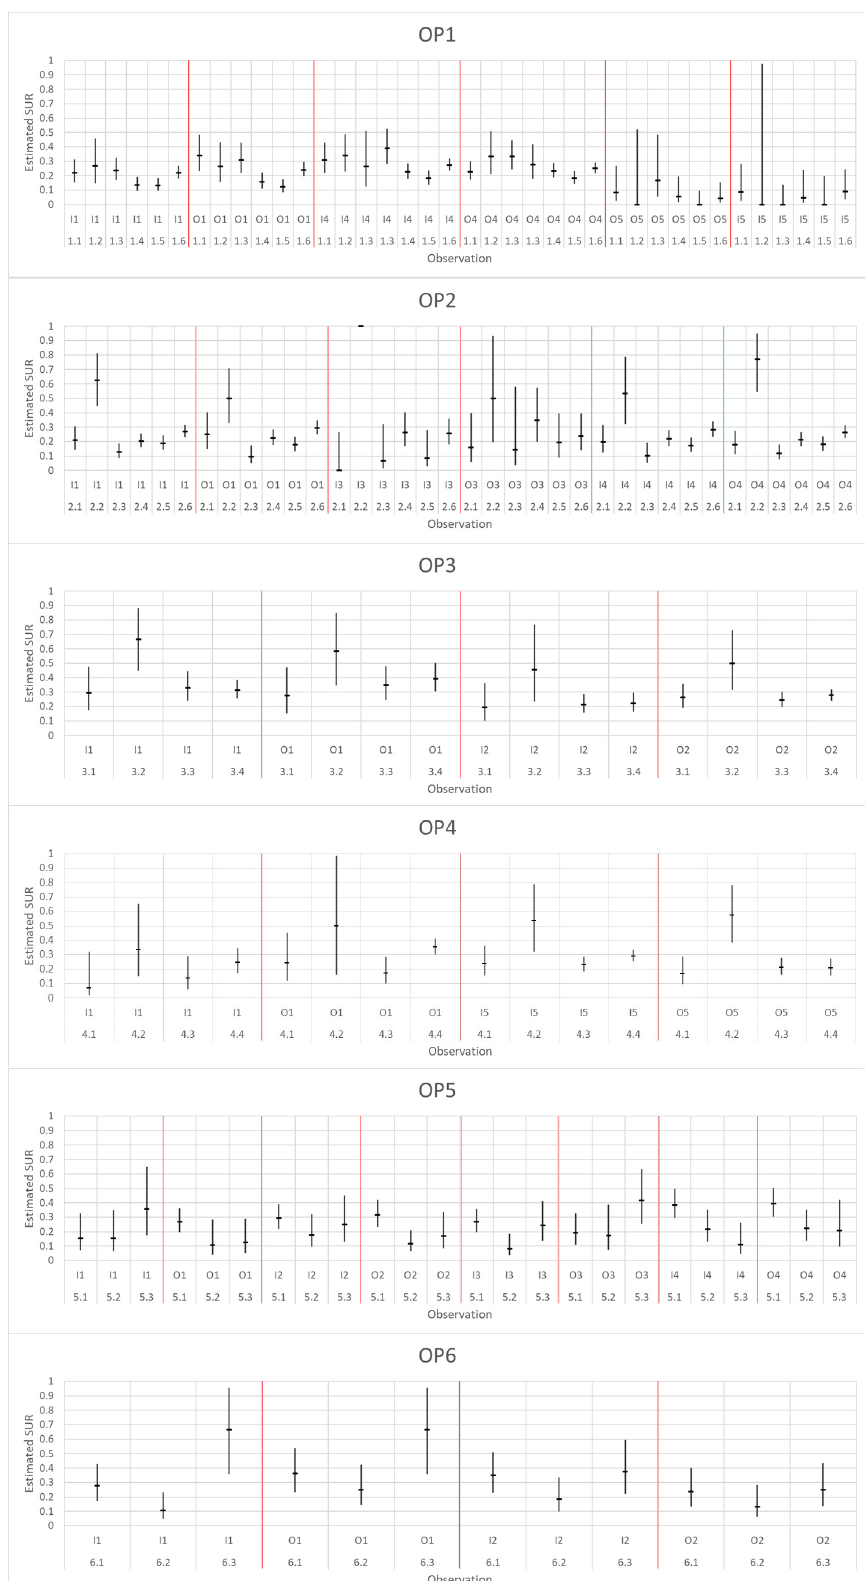
Figure 4. Global SUR for all observation points, segments, and observation days.